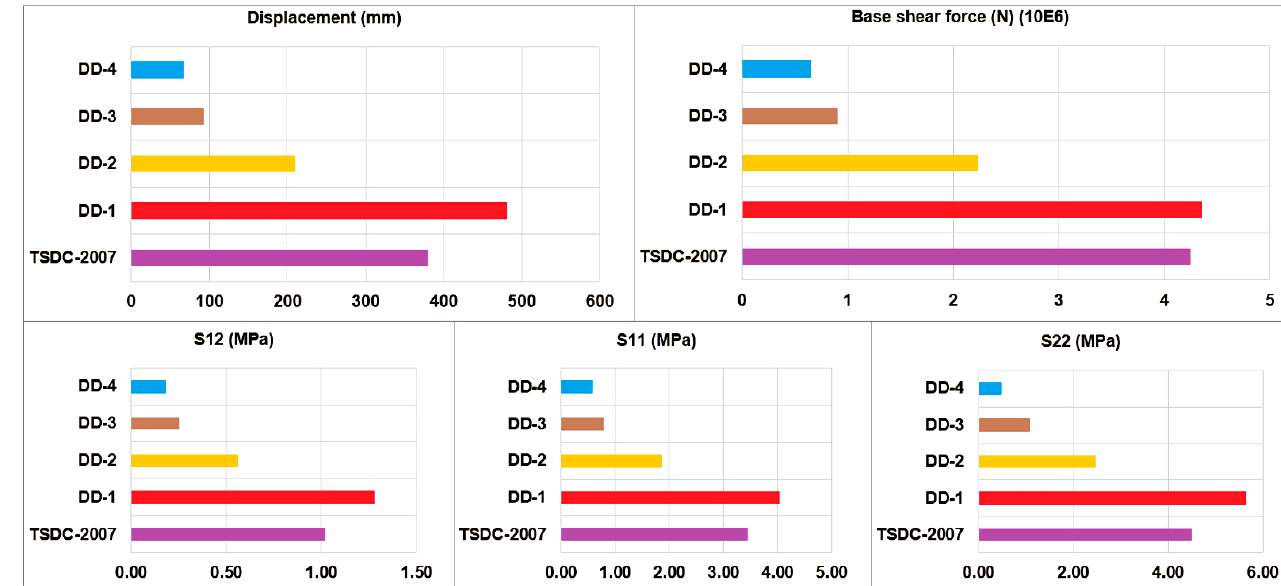
Figure 26. Comparison of result values for different probabilities.